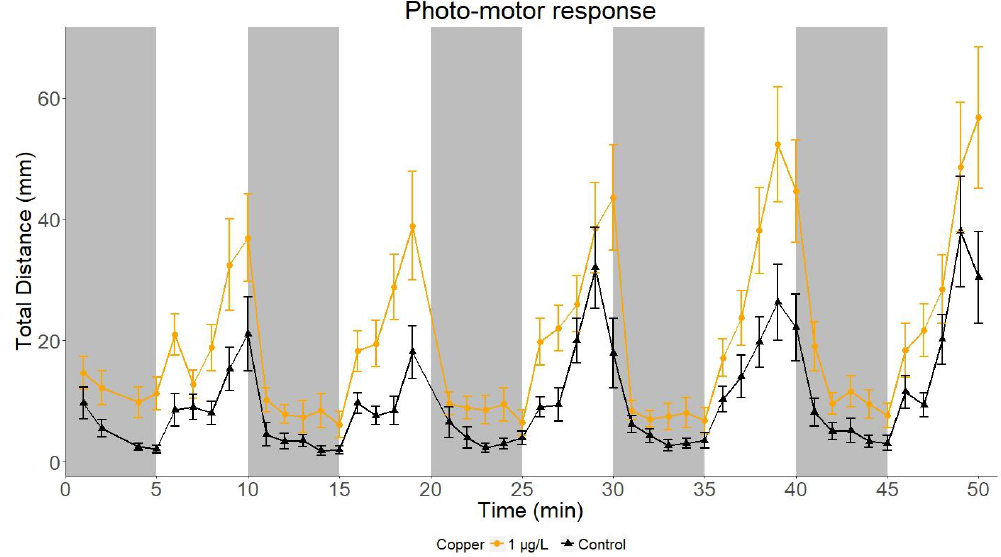
Figure 1. Photo-motor response of sand goby larvae exposed to copper (1 μ g/L, n = 31) compared to control larvae ( n = 38), tested under five cycles of light (white) and dark (shaded) conditions.